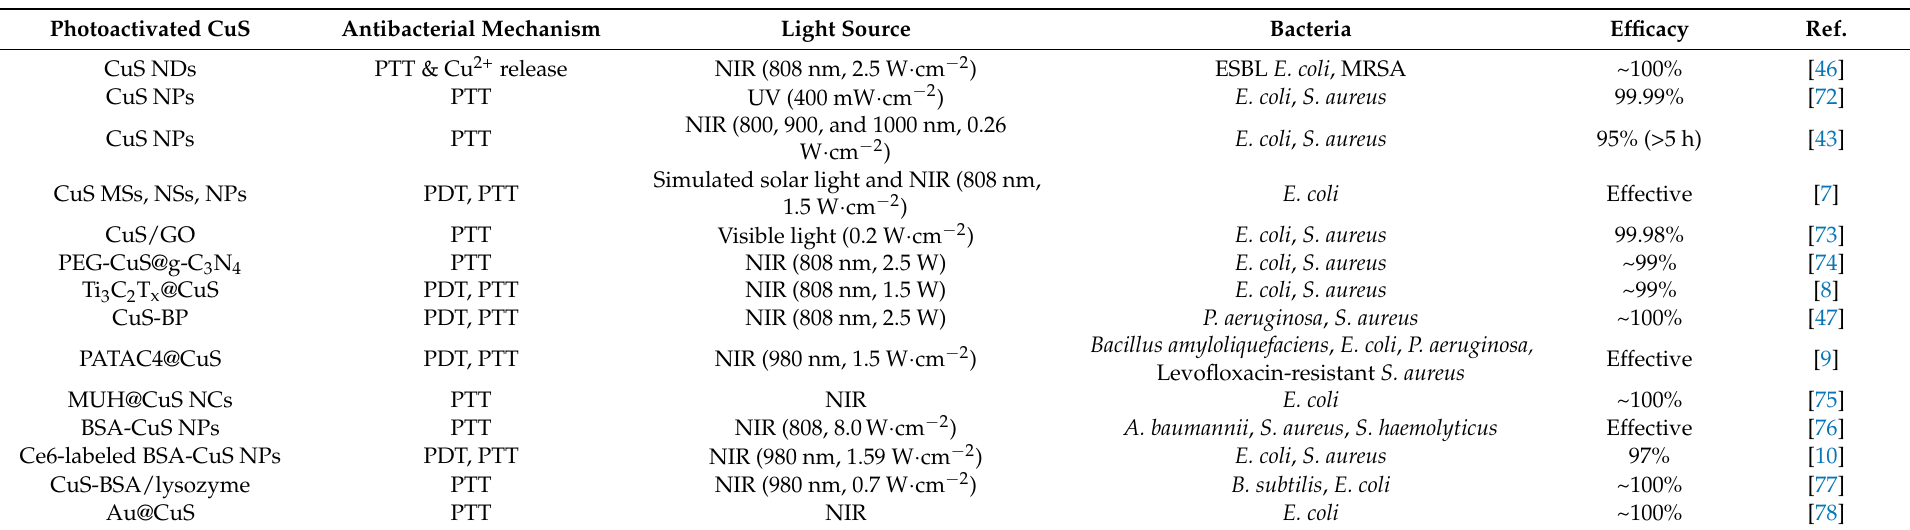
Table 1. Antibacterial activity of phoactivated CuS